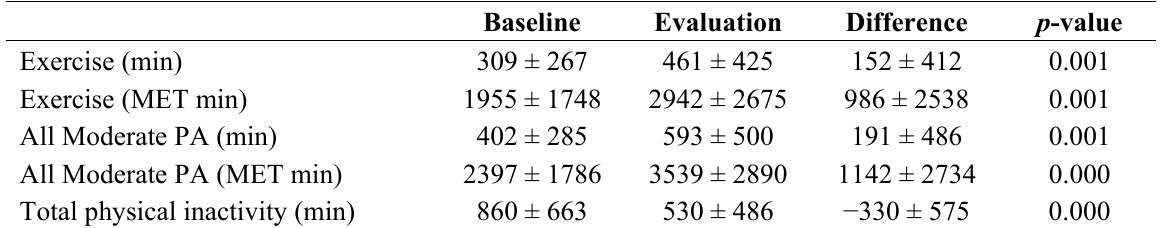
Table 3. Seven-day Physical Activity Questionnaire (PAQ) Results